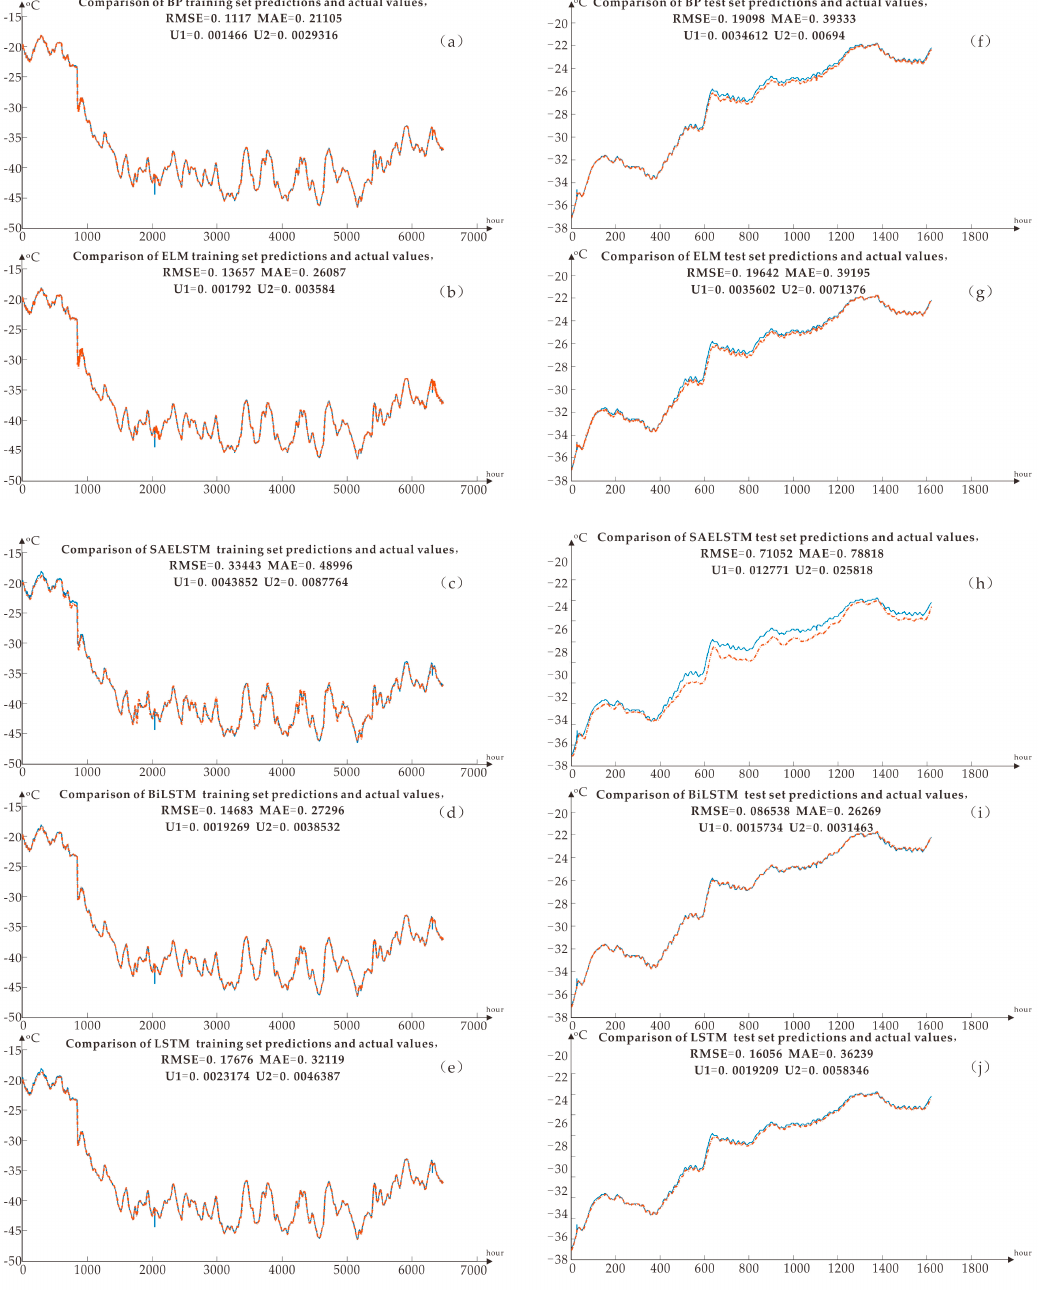
Figure 11. ( a ) BP neural network training set training result ( b ) ELM neural network training set training result ( e ) LSTM neural network training set training Results ( f ) BP neural network test set training results ( g ) ELM neural network test set training results ( h ) SAELSTM neural network test set training results ( i ) Bi LSTM neural network test set training results ( j ) LSTM neural